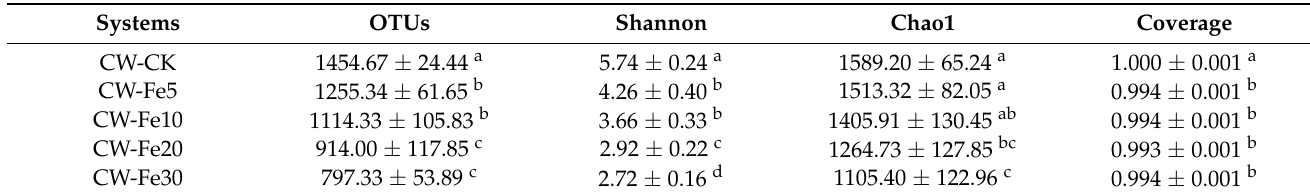
Figure 4. The pH value at 72 h. Table 2. Summary statistics of microbial community diversity indices in